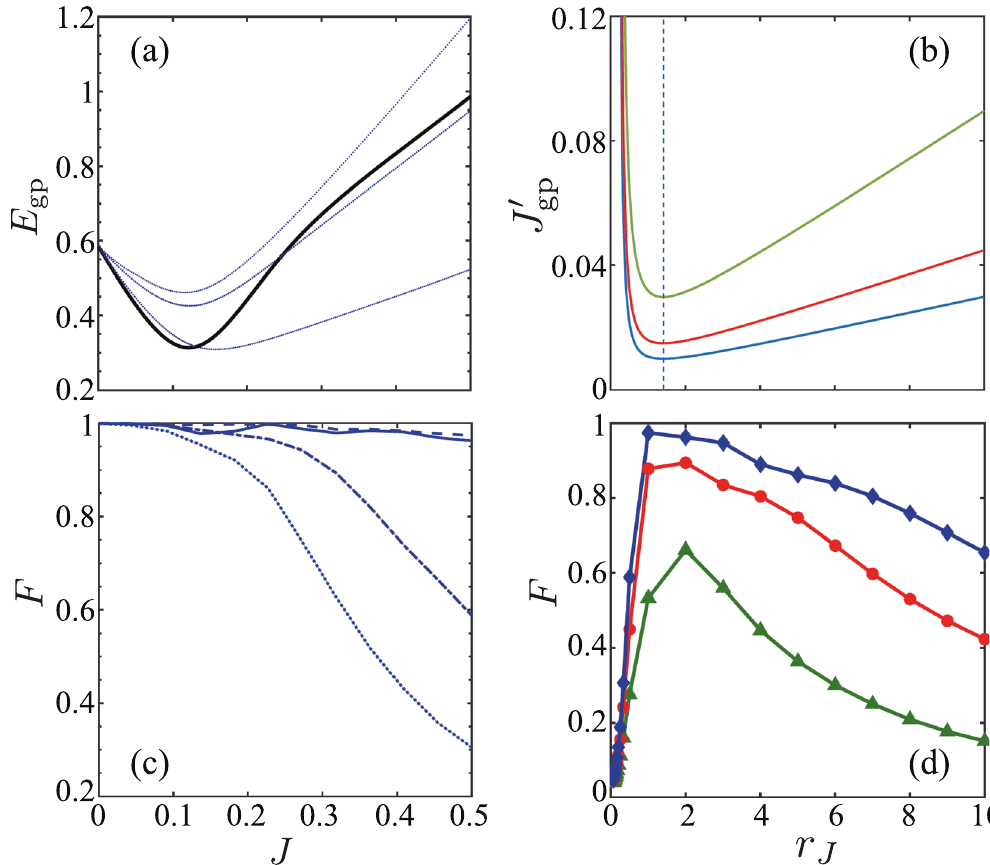
Fig. 3 Ramping from MI to SF phase. a Energy spectrum of the lowest excited states vs hopping rate J . Solid (dotted) curve is for the symmetric (asymmetric) state with the ground-state energy set to zero. b Time derivative J 0 10 π / g , and 15 π / g from top to bottom. c Fidelity F vs J ( T ) = J for r J = 2 (solid), 1 (dashed), 1/2 (dot-dashed), and 1/3 (dotted) at T = 15 π / g . d Fidelity F vs r J at J ( T ) = 0.5 and T = 5 π / g , 10 π / g , and 15 π / g from bottom to top. In all plots, g ( t ) ≡ 1, J (0) = 0, and Δ ( t ) ≡